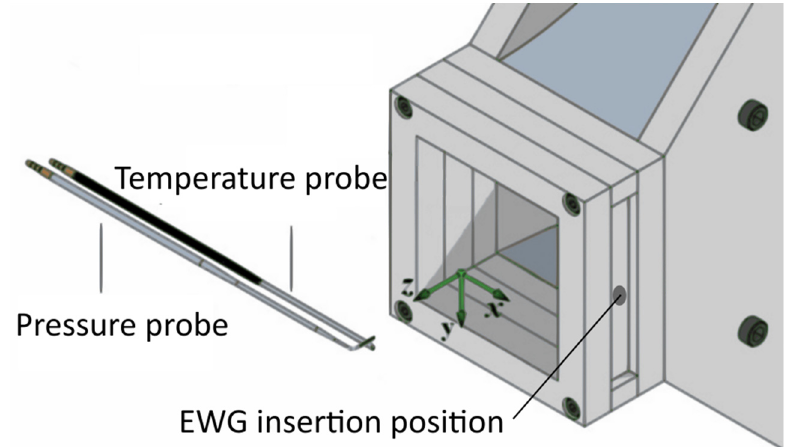
Figure 5. Wind tunnel reference system.